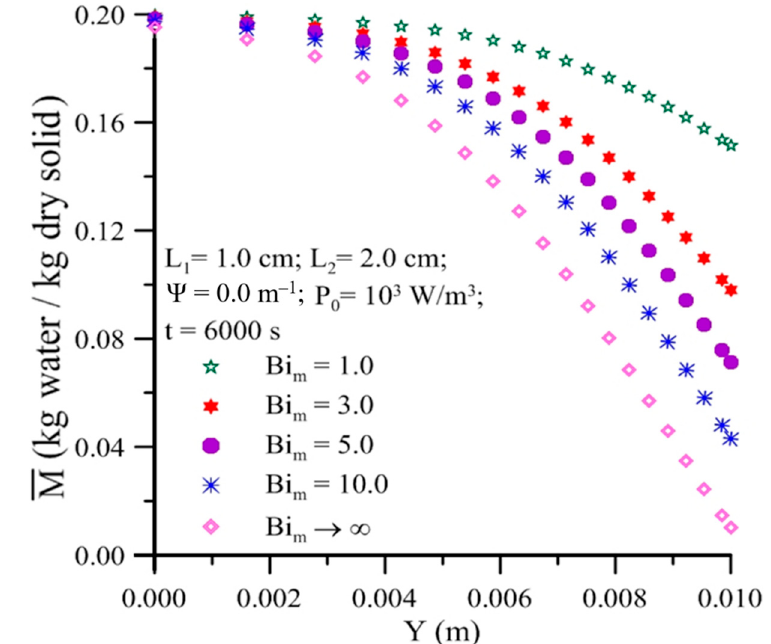
Figure 9. Moisture content inside a prolate spheroidal solid with aspect ratio L 2 /L 1 = 2.0, different mass transfer Biot numbers and fixed microwave power density ( y -axis, z = 0, t = 6000 s).